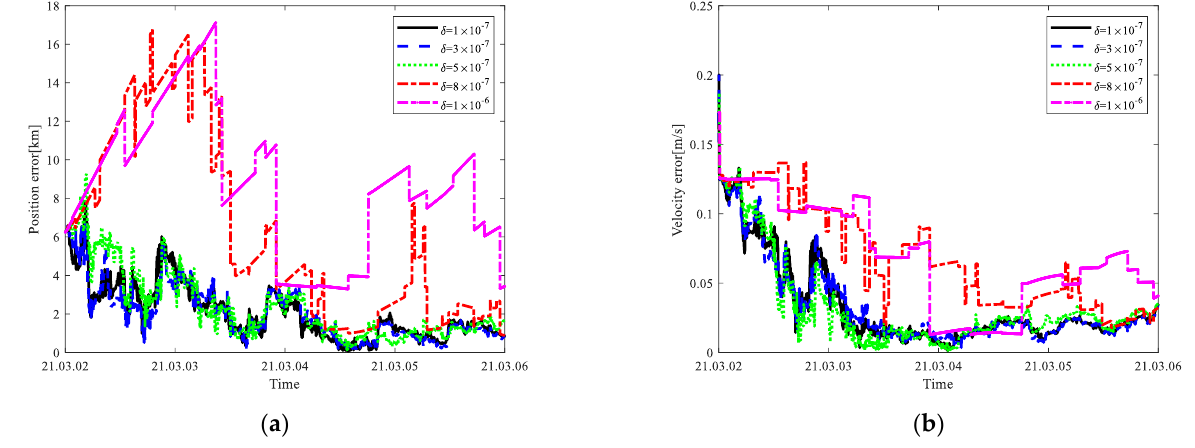
Figure 5. Navigation results of the parameter-dependent event-triggered mechanism based on innovation. ( a ) Position error. ( b ) Velocity error. Table 5. Navigation results with different .